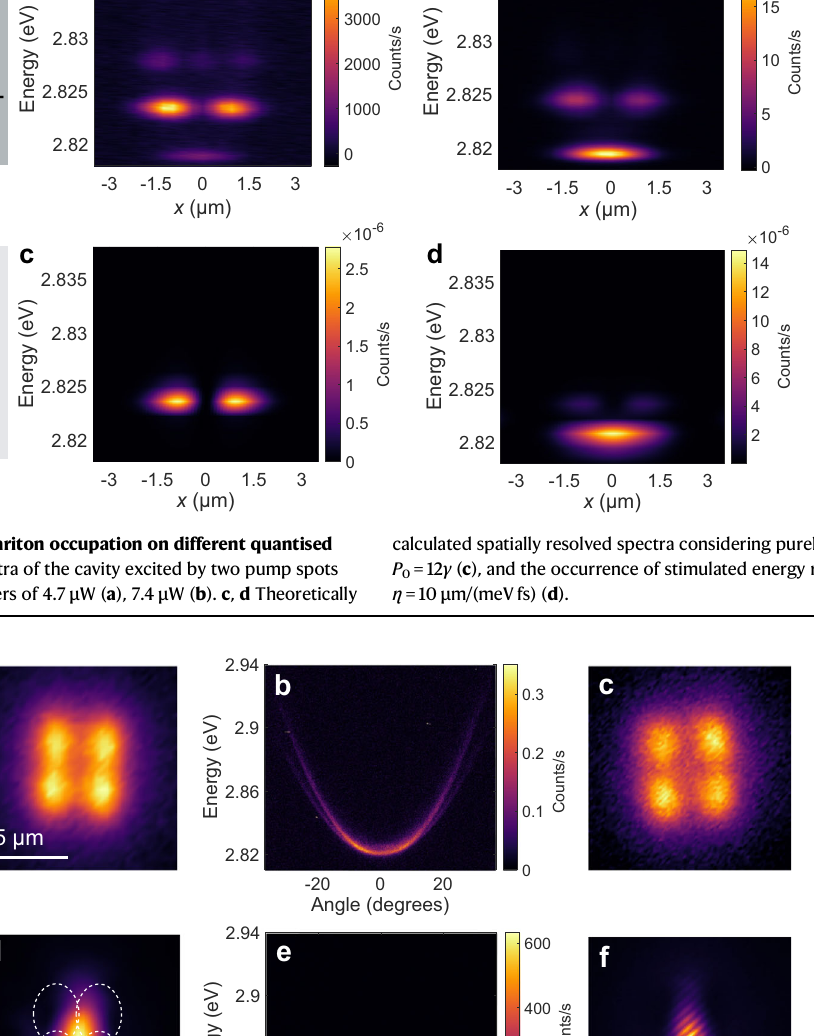
Fig. 4 | Characterisation of single-mode condensate in two-dimensional trap- ping. a – c Real-space image, angle-resolved PL, and interferogram of the cavity pumped byfour laser spots (5.8 μ m×4.4 μ m each) with centres locatedatvertices